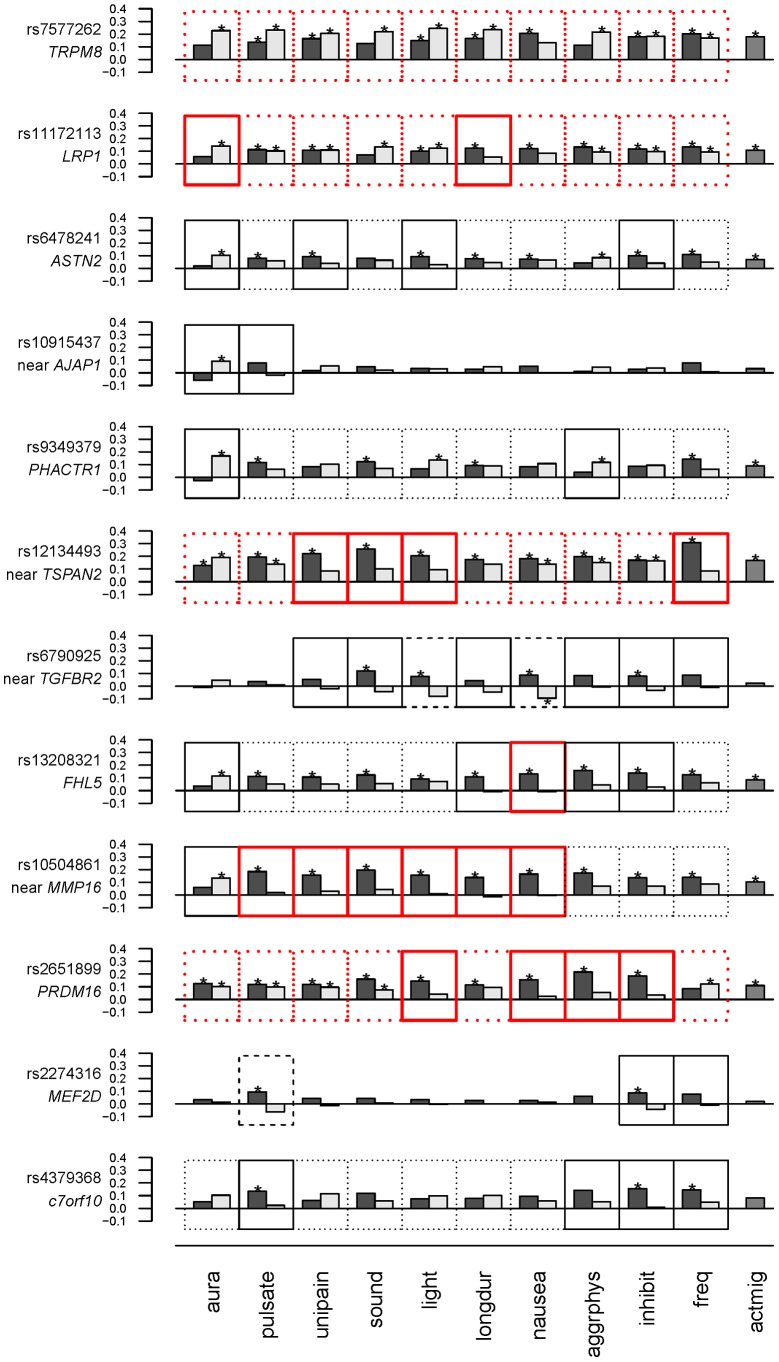
Estimates (beta coefficients) for association in the WGHS from logistic models for each of the 12 candidate SNPs as predictors of migraine accompanied by aura or other characteristics (black bars), or not (gray bars).Significant associations are indicated with “*” (see also Table S4). Model selection results (Tables 3 & 4) are indicated with outlines around each plot as follows: Non-null models selected using the BIC are indicated with a heavy red outline, while non-null models selected using the AIC are indicated with a thin black outline. “Subset” or “inverse subset” models (see Methods) are indicated with a solid outline, “basic” models are indicated with a dotted outline, and “general” models are indicated with a dashed outline. Migraine characteristics considered were aura, pulsating pain ( = pulsate), unilateral pain ( = unipain), phonophobia ( = sound), photophobia ( = light), duration of 4–72 hours ( = longdur), nausea, aggravation by physical activity ( = aggrphys), inhibition of daily activities ( = inhibit), ≥6 attacks/year ( = freq). The rightmost column (actmig) indicates association estimates for active migraineurs, irrespective of status for the characteristics (see Methods). The order of SNPs is derived from clustering as in Figure S1. See also Methods.